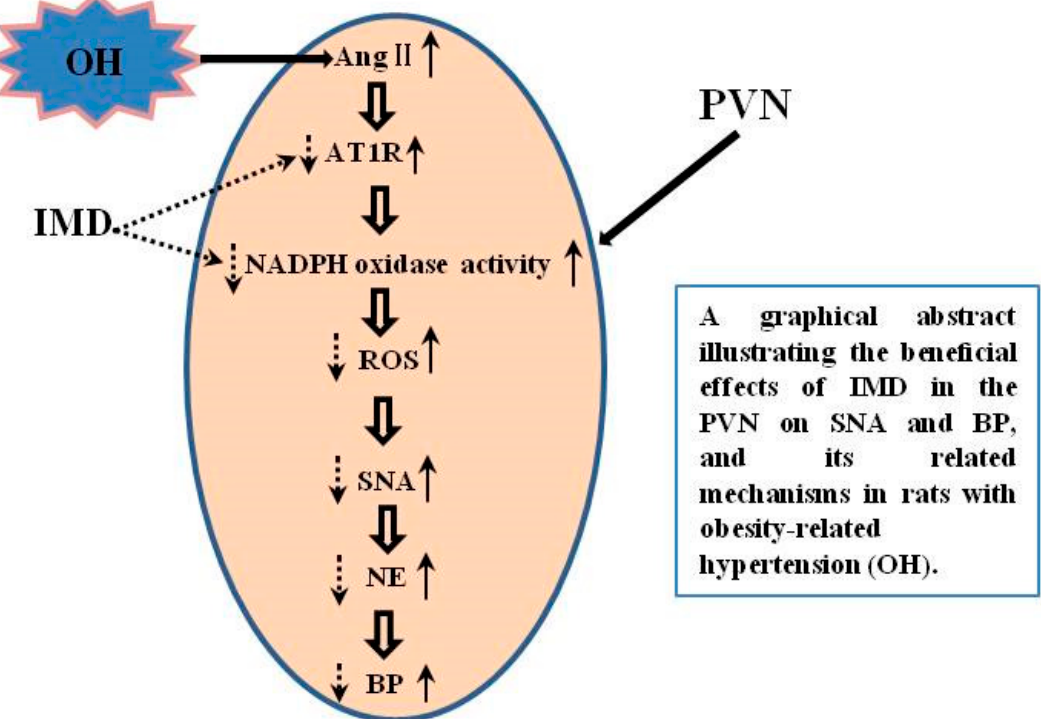
Figure 9. A schematic diagram showing the inhibitory effects of IMD in the PVN on SNA and BP, and its related mechanisms in rats with obesity-related hypertension (OH). IMD effectively prevents the enhanced SNA caused by increased reactive oxygen species (ROS) and improves hypertension via the inhibition of AT1R protein expression and NADPH oxidase activity. The up arrow with dotted line represents increase and the down arrow with solid line represents decrease.